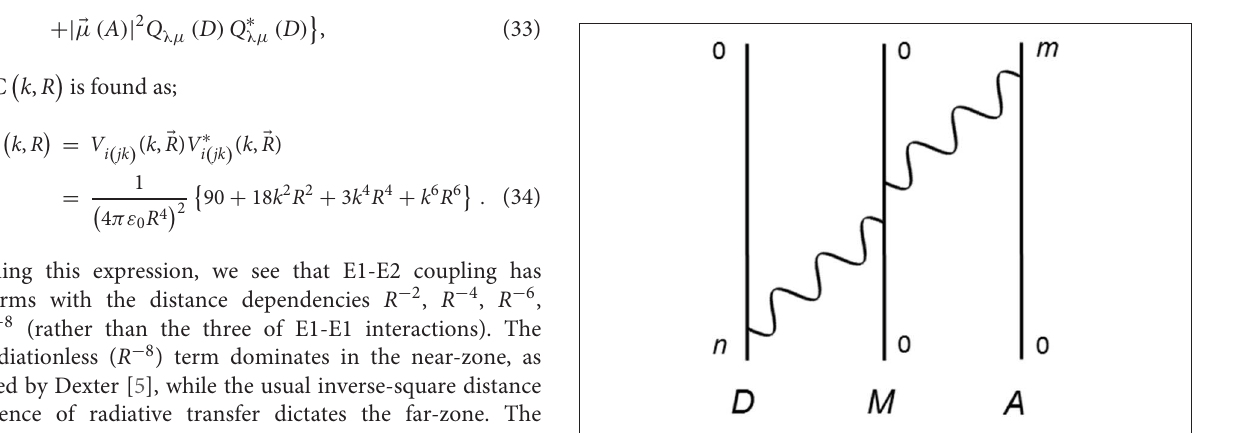
FIGURE 3 | One of 24 possible time-orderings for RET mediated by a third molecule, M , acting as a bridge between donor D and acceptor A . Energy is transferred from D to A , and M begins and ends in its ground